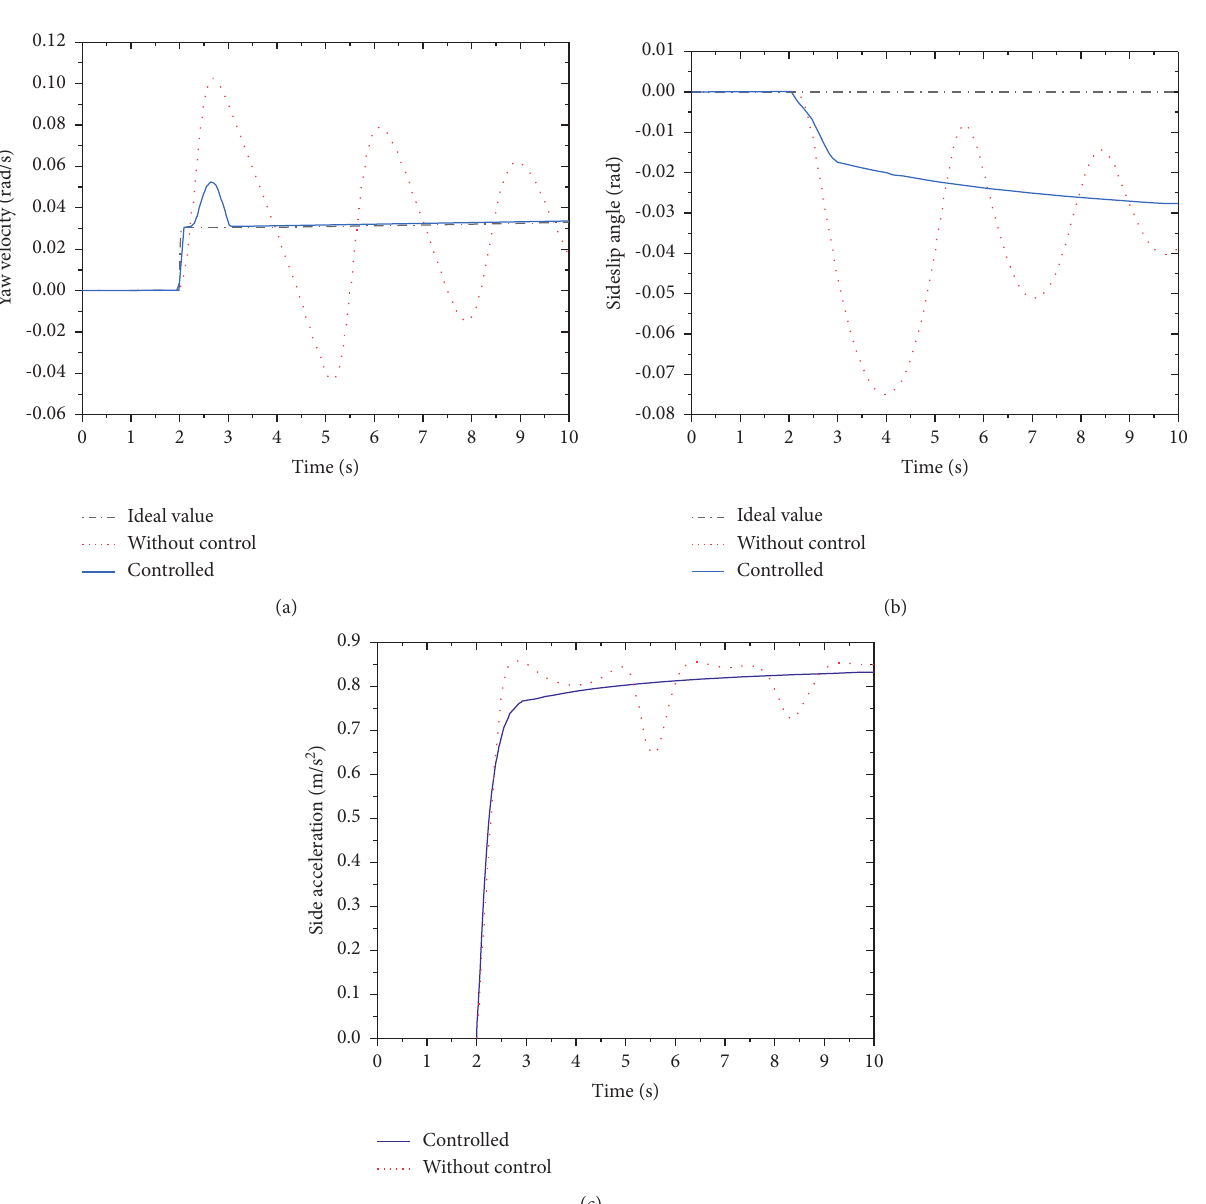
Figure 11: Simulation results of front-wheel angle overstep at an initial speed of 100km/h. (a) Change of yaw rate. (b) Change of sideslip angle of centroid. (c) Change of lateral